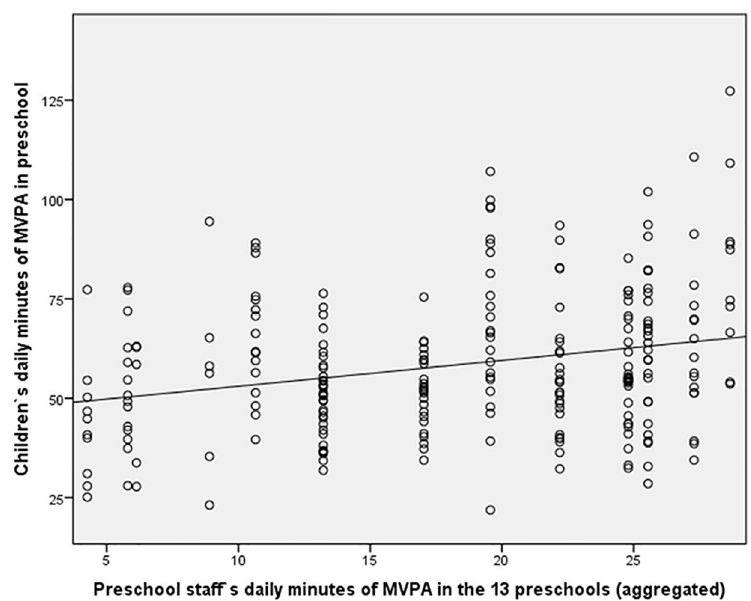
Fig 2. Associations between preschool staff’s aggregated MVPA and children‘s individual average MVPA during preschool hours.